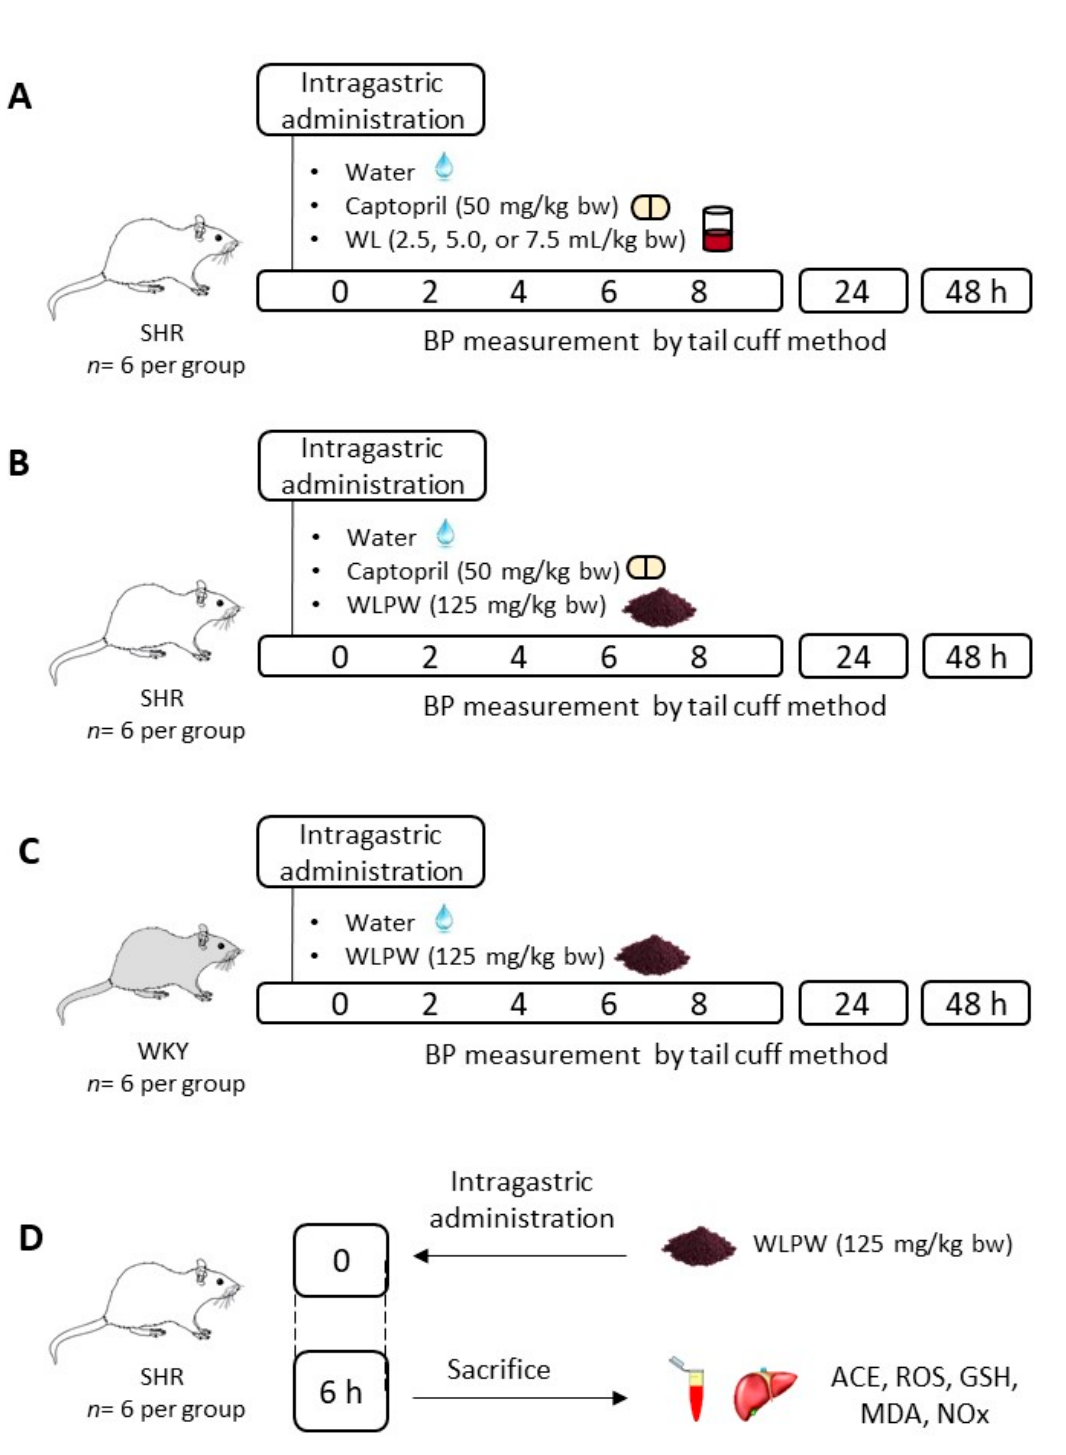
Figure 1. Experimental design of the different in vivo studies. ( A ) Effect of 3 different doses (2.5. 5.0 and 7.5 mL/kg bw) of wine lees (WL) on blood pressure (BP) in spontaneously hypertensive rats (SHR). ( B ) Effect of dried WL powder (WLPW) on BP in SHR. ( C ) Effect of WLPW on BP in normotensive Wistar Kyoto rats (WKY) and ( D ) mechanisms involved in the antihypertensive effect of WLPW in SHR at 6 h post-administration. ACE: angiotensin-converting enzyme; ROS: reactive oxygen species; GSH: reduced glutathione; MDA: malondialdehyde; NOx: nitric oxide metabolites.